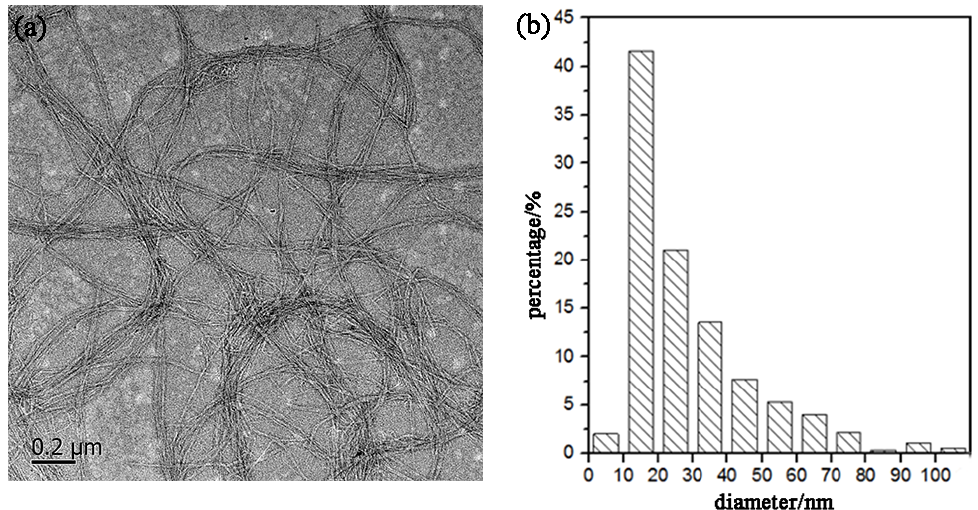
Figure 5. ( a ) Transmission electron microscope (TEM) image and ( b ) diameter distribution of the CNFs.